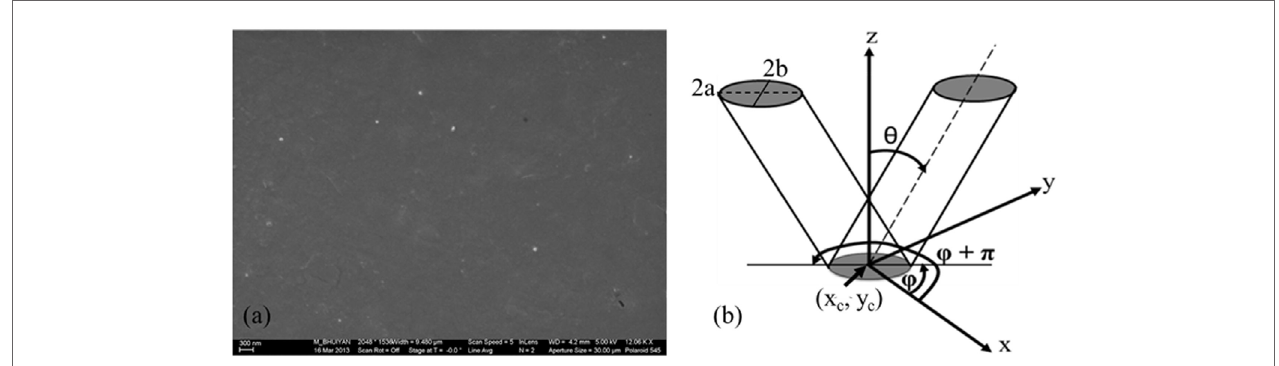
FigUre 1 | (a) Representative SEM image of 4 wt% CNT/PP composites; (B) definition of in-plane ( φ ) and out-of-plane ( θ ) angles used to describe CNT